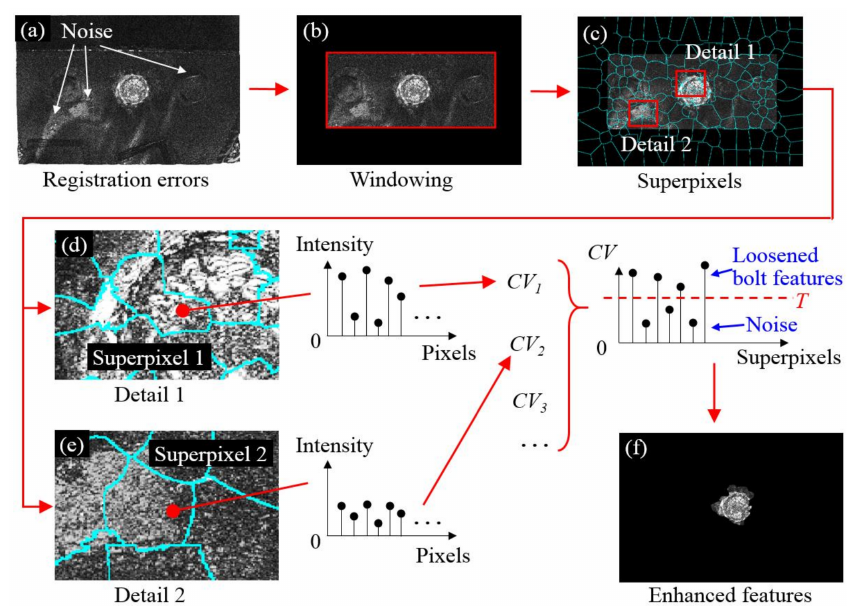
Figure 5. Methodology of feature enhancement: ( a ) registration errors; ( b ) registration errors after windowing; ( c ) segmentation of the registration errors by superpixels; ( d ) detail of Superpixel 1; ( e ) detail of Superpixel 2; and ( f ) registration errors after feature enhancement. The brightness of all figures is enhanced for demonstration purposes.